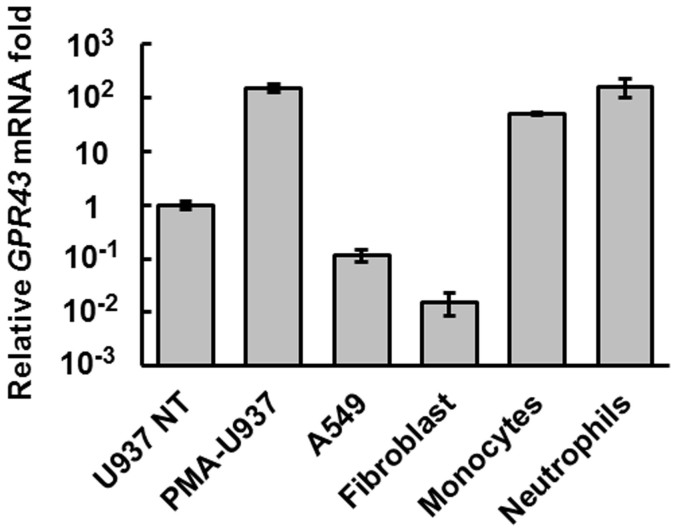
GPR43 mRNA is up-regulated in primary human monocytes, neutrophils and PMA differentiated U937 cells as determined by quantitative PCR.Results shown are standardized to undifferentiated U937 cells and error bars represent the mean ± s.d. of three independent cell cultures.